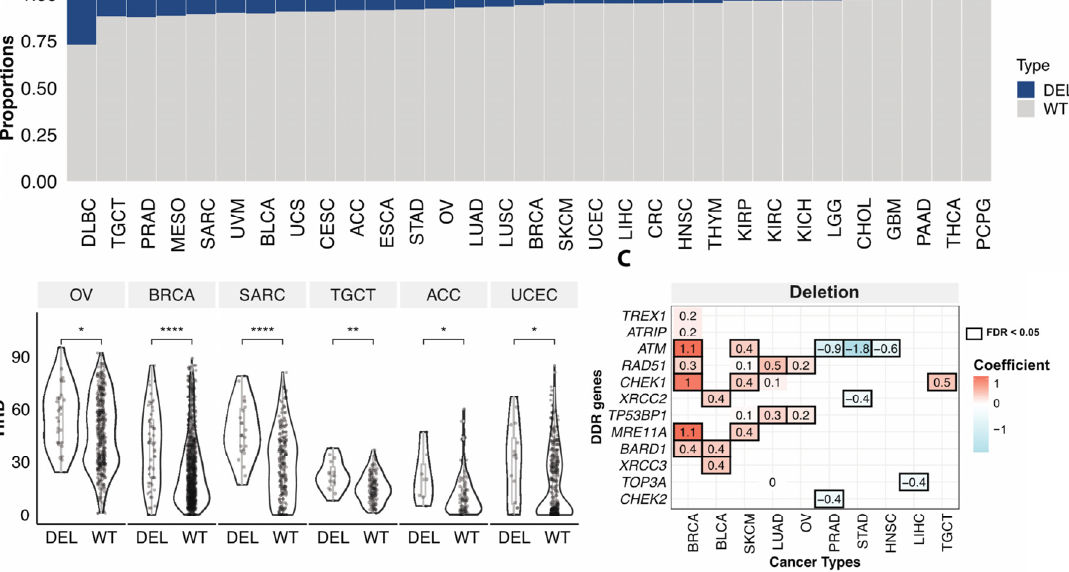
Figure 4. Somatic copy number deletions of HR genes associated with HRD. ( A ). The proportions of samples with somatic copy number deletion of homologous recombination and damage sensor genes in each cancer type. Blue (loss) indicates samples with somatic copy number deletions in any of 28 HR genes (excluding BRCA1/2), grey (WT) denotes non-mutated cases. ( B ). The HRD score between cases with somatic copy number deletion (DEL) of homologous recombination and damage sensor genes and wildtype (WT) cases excluding BRCA1/2 copy number variation affected cases in OV ( n = 28 (DEL), 332 (WT)), BRCA ( n = 53 (DEL), 860 (WT)), SARC ( n = 23 (DEL), 193 (WT)), TGCT ( n = 15 (DEL), 113 (WT)), ACC ( n = 7 (DEL), 74 (WT)), UCEC ( n = 16 (DEL), 303 (WT)). p -value was calculated using a two-sided Mann–Whitney test and FDR corrected. “****”, “**”, “*” denote FDR less than 0.00001, 0.001, and 0.05. ( C ). The heatmap shows the significant (FDR < 0.05, black box) association of somatic copy number deletion of individual genes with the HRD of TCGA cancer types. Both value and color in each cell represent the coefficient obtained from the multivariate logistic regression